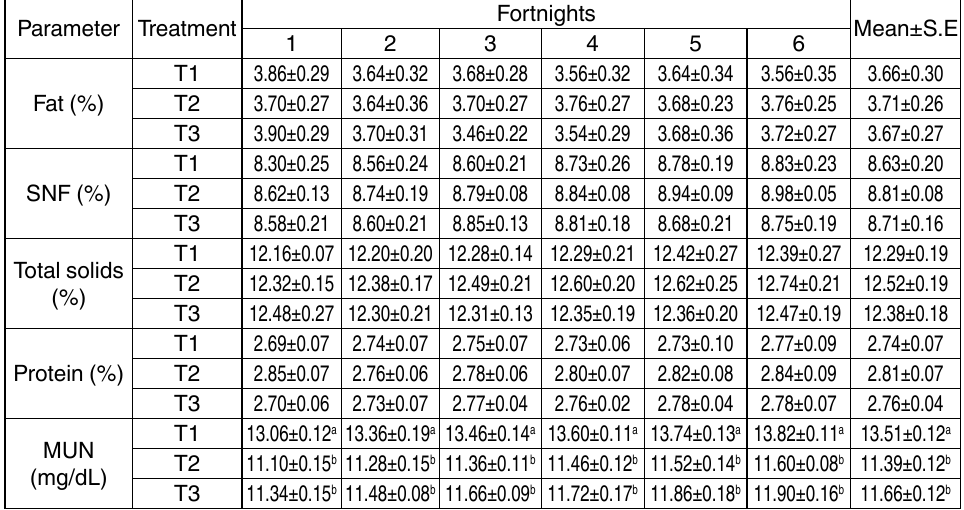
Table 4. Fortnightly average milk composition 1 of lactating cows maintained on three experimental rations,